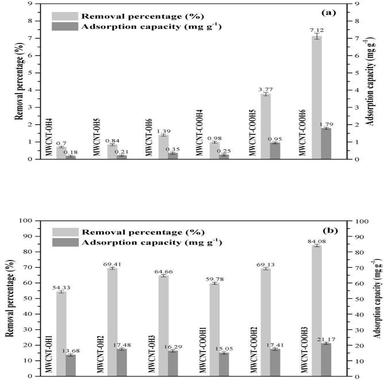
Removal percentage and adsorption capacity of modified MWCNTs (a) less concentrated and (b) high concentrated, for the adsorption of GLY.